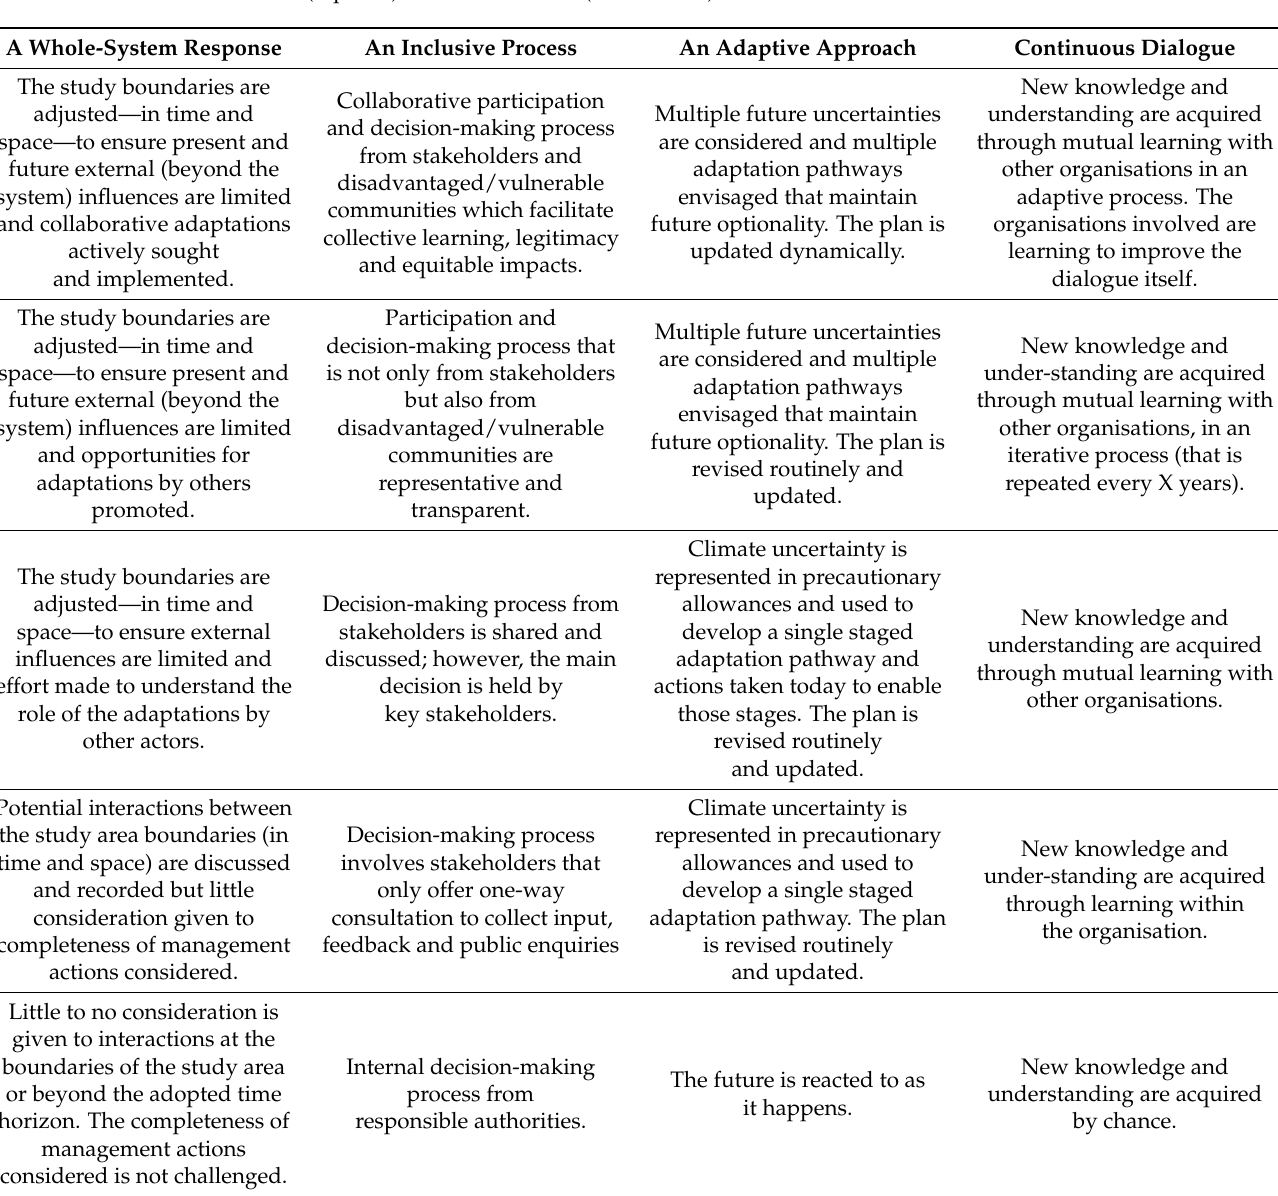
Figure 2. Five-point scale along which maturity can be increased incrementally (adapted from Williams et al. [46]). Table 2. Cloud to Coast maturity model, using a five-point scale ranging from an optimised level (top row) to an ad hoc level (bottom row).